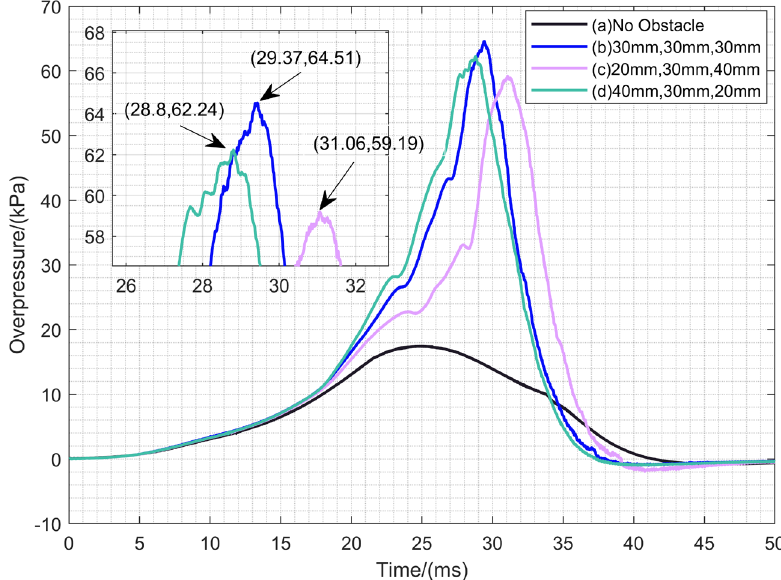
Figure 8. Pressure comparison of the four working conditions.